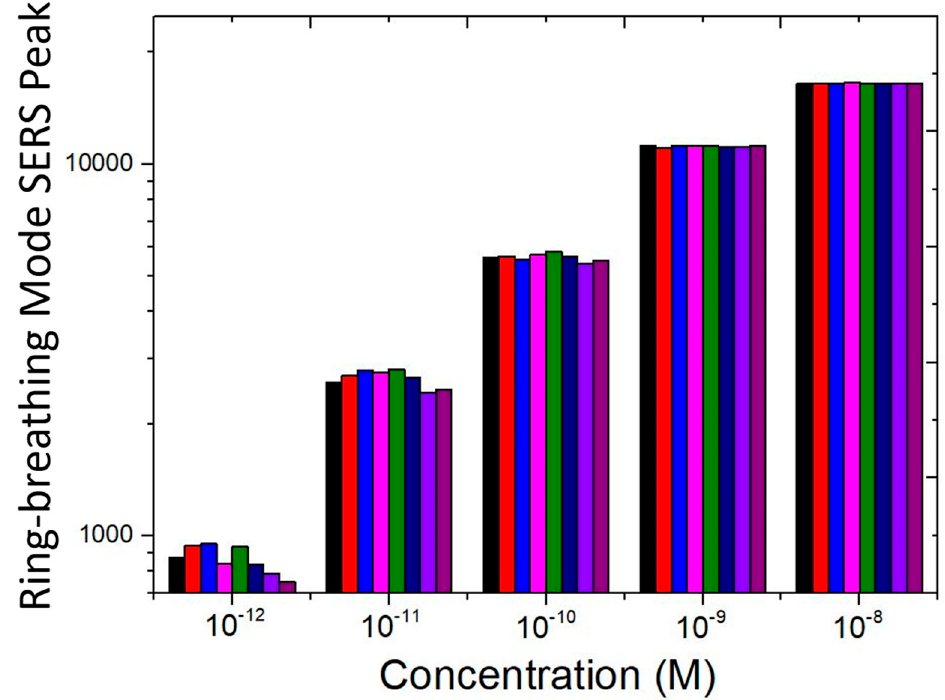
Figure 8. Reproducibility of SERS signal strengths of the ring-breathing mode vibration measured by eight SERS sensors (displayed in different colors) from pH 9 adenine aqueous solution. The reproducible and concentration dependent adenine SERS shift has additional